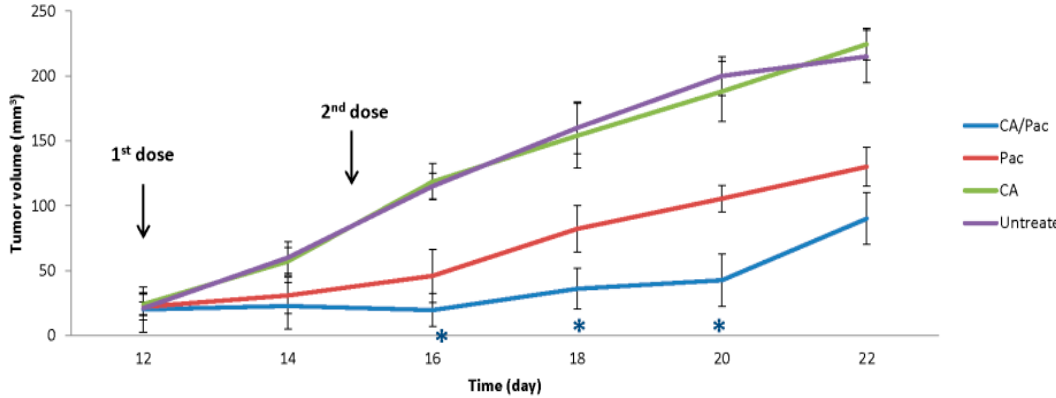
Figure 10. Effect of carbonate apatite particles and particle-bound Pac on a 4T1-induced tumour mouse model. Mice were purchased from the School of Medicine and Health Science animal facility, Monash University, Malaysia. Approximately 10 5 4T1 cells were inoculated subcutaneously on the mammary pad of mice on day 1 of the study. Based on tumour volume calculations, mice were randomized and treated intravenously through tail-vein injection on day 12 and 15. The therapeutics included 100 μ L of HCO 3 -DMEM containing carbonate apatite formed with 7 μ L of 1 M CaCl 2 with/without 1.25 mg/kg Pac or 1.25 mg/Kg free Pac. Body weight and tumour outgrowth were recorded every other day. Six mice were used per group and data are presented as the mean ± SD of tumour volume. Values are significant with a * p value < 0.05 for CA/Pac compared to the free pac group.